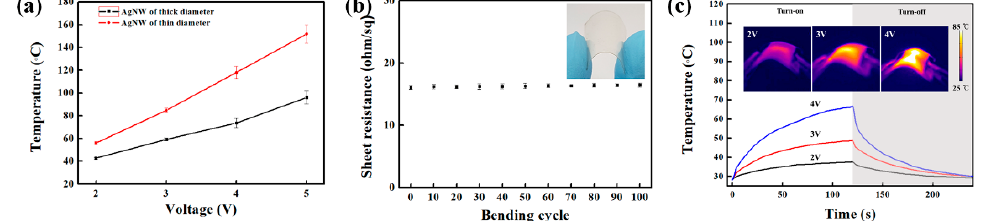
Figure 7. ( a ) The voltage-dependent temperature evolution, ( b ) sheet resistance variation, and ( c ) time-dependent temperature of Ag NWs network-based flexible film heaters at different voltages. The bending test was repeatedly performed to 7 mm bending radius.